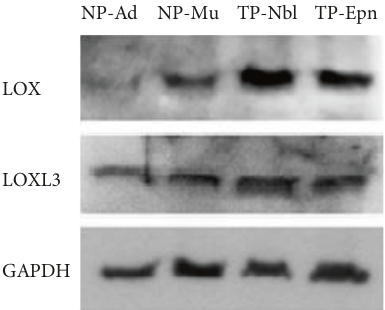
Figure 4: LOX and LOXL3 protein levels in normal and tumor- associated pericytes. Representative Western blots for each protein are shown. Normal pericyte samples: NP-Ad and NP-Mu. Tumor- associated pericyte samples: TP-Nbl and